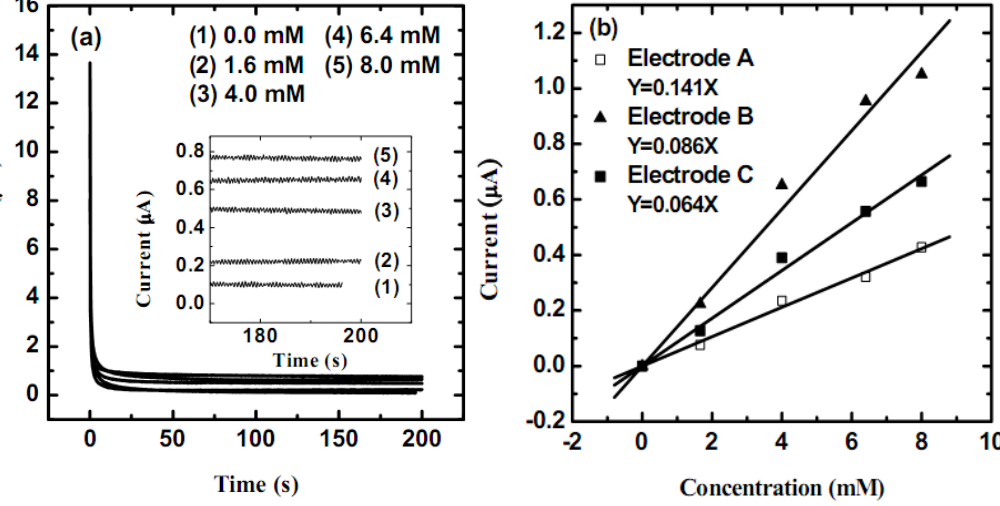
Figure 7. (a) The current responses of the cholesterol at different concentrations